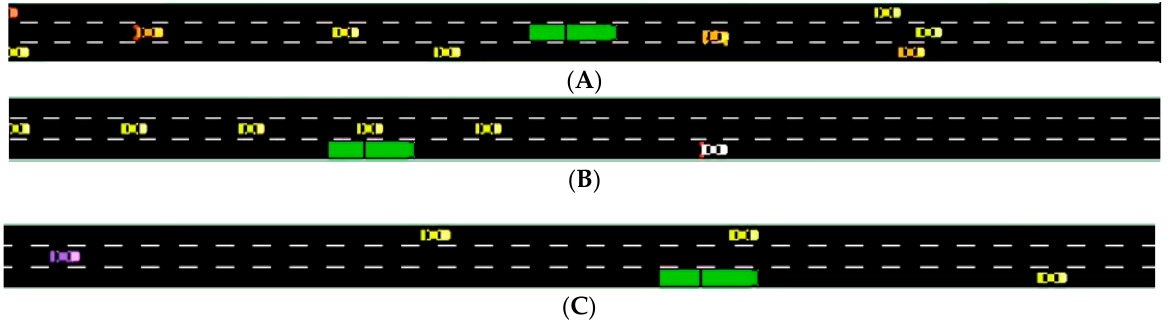
Figure 3. Three types of scenarios: ( A ) normal scenario, ( B ) stop scenario, and ( C ) speeding scenario. Green vehicle is ego vehicle, white vehicle is stationary vehicle, and purple vehicle is speeding vehicle. The other nearby vehicles are closer to red as the speed increases.